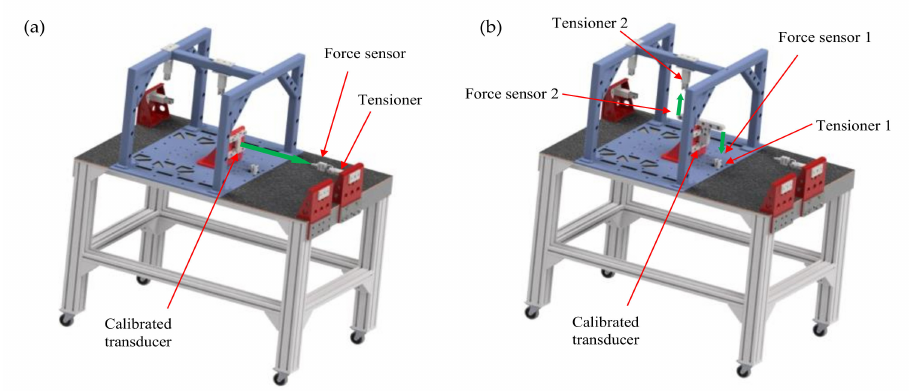
Figure 11. Transducer calibration, ( a ) Fx, ( b )